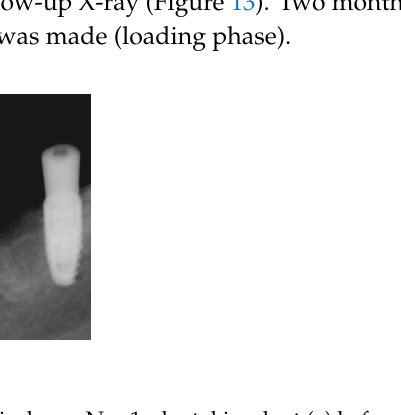
Figure 13. Clinical case No. 1: dental implant ( a ) before and ( b ) after the treatment.